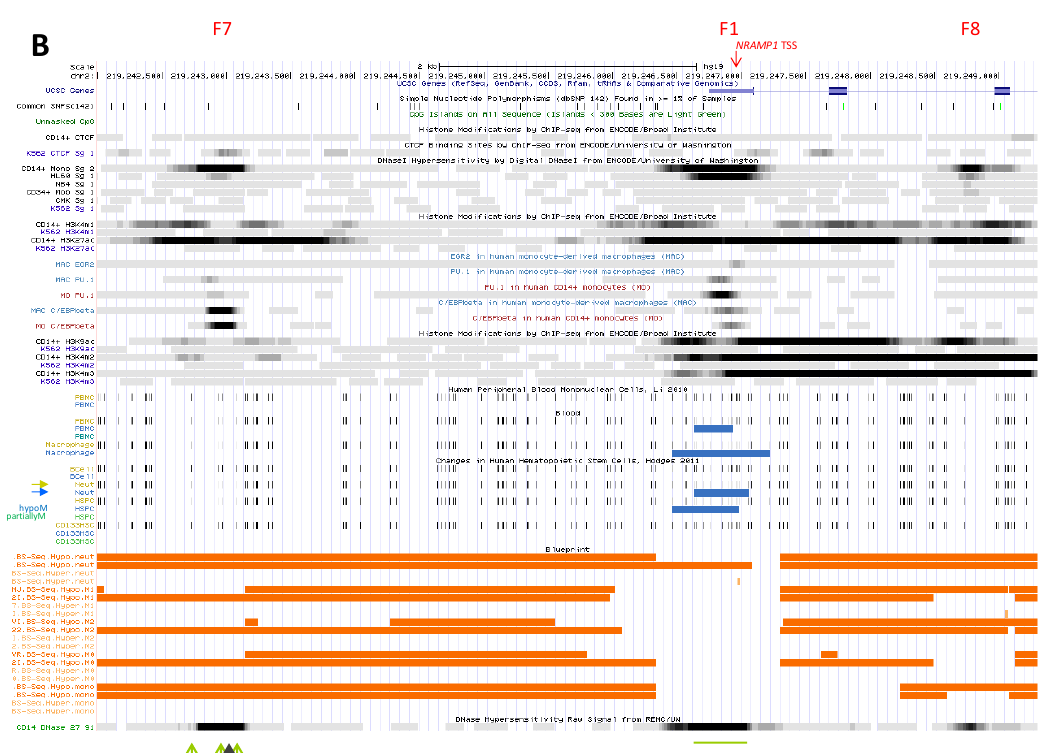
Figure 3. Epigenetic modifications at NRAMP1 locus region iii, encompassing Dnase1 footprints F7, F1 and F8 (described in text Sections 2.2.3.5, 2.2.3.6 and 2.3.1.3, respectively). ( A ), ( B ) same as Figure 2.